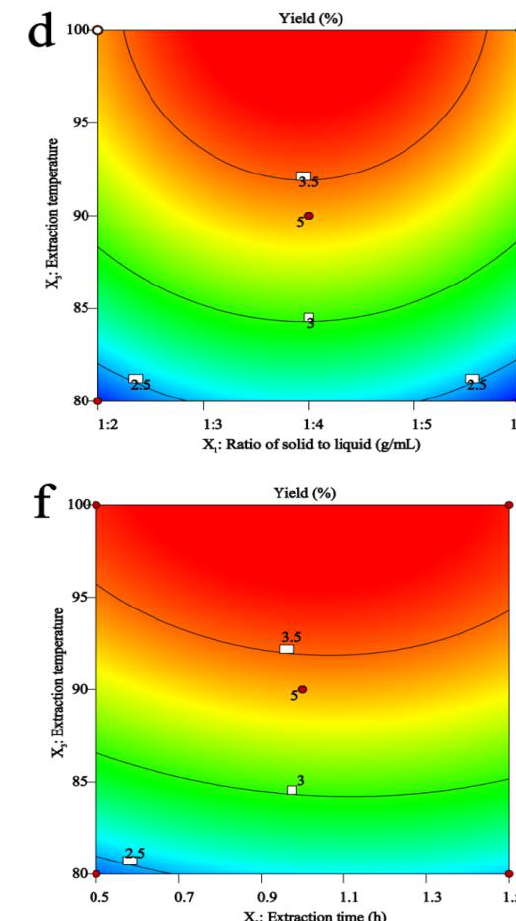
Figure 2. Effects of solid-liquid ratio, extraction time, and temperature on the yield of MAP-2. Effects of different extraction time and solid-liquid ratios ( a , b ), extraction temperatures and solid-liquid ratios ( c , d ), extraction temperatures and extraction time ( e , f ) on the yield of MAP-2. to different extraction time and temperature under the condition of fixed solid-liquid